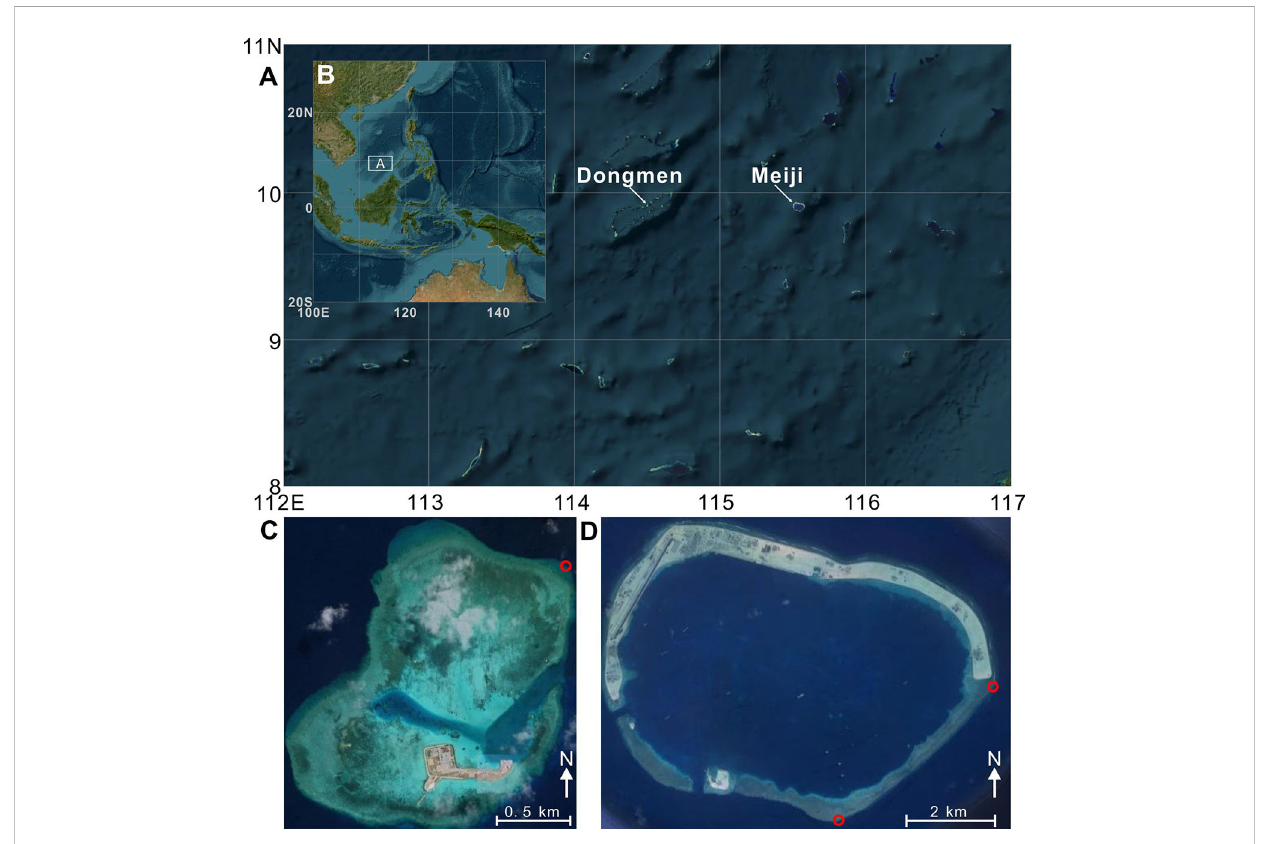
FIGURE 1 The Nansha Archipelago (A) is in the tropical South China Sea, western Paci fi c (B) . Two atolls, Dongmen (C) and Meiji (D) , are located in the north of Nansha region. Red circles indicated the locations of core sampling and ecological surveys. Satellite images were downloaded from the NOAA Marine Trackline Geophysical Data